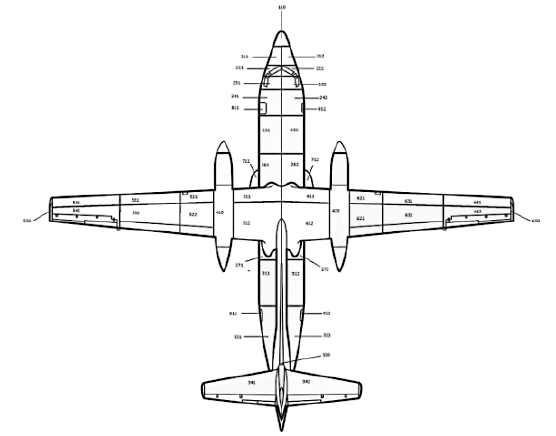
Fig. 5. ZSA aircraft zones (Koštial 2012)